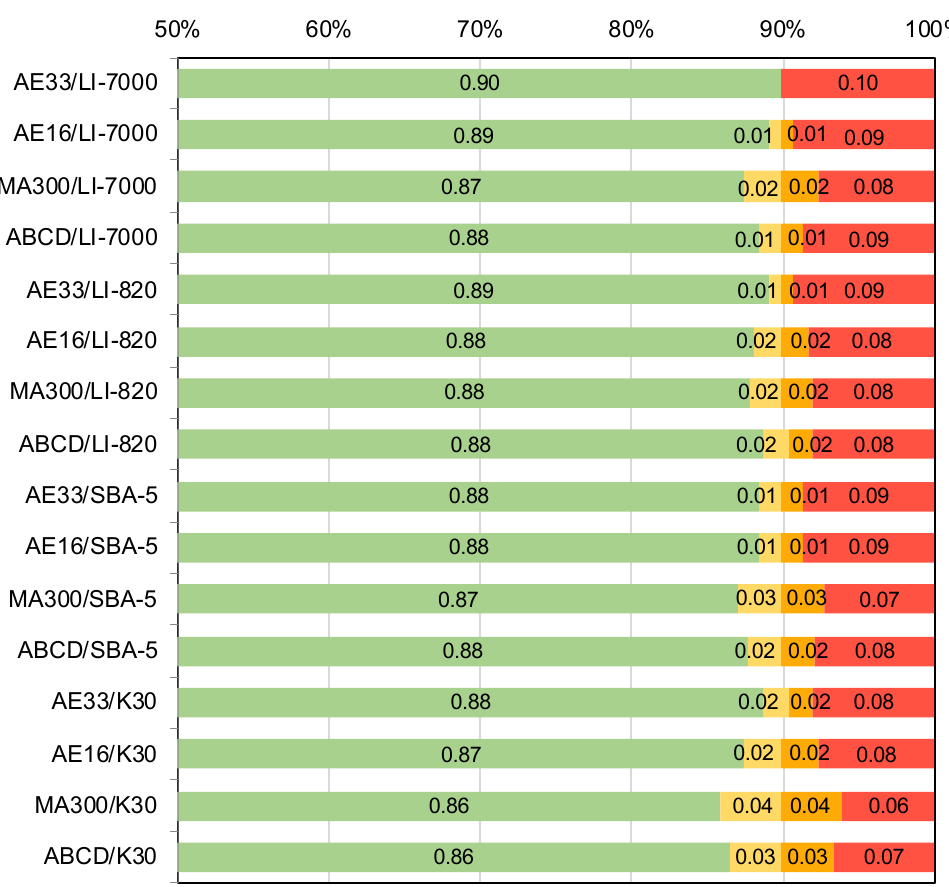
Figure A9. Agreement of high emitter classification all sensor pairs for the Arterial Road fleet. Relative to the highest-emitting 10% of each fleet identified by the highest-cost pair, the AE33 / LI-7000, emission factor distributions for alternative sensor pairs are categorized by those trucks that are also identified as high-emitting (red) and not (green), versus those that disagree and are false positives (yellow) or false negatives (orange). Each bar adds up to 100% of the sampled fleet. Due to rounding, the sum of high emitters and false positives and false negatives may not equal